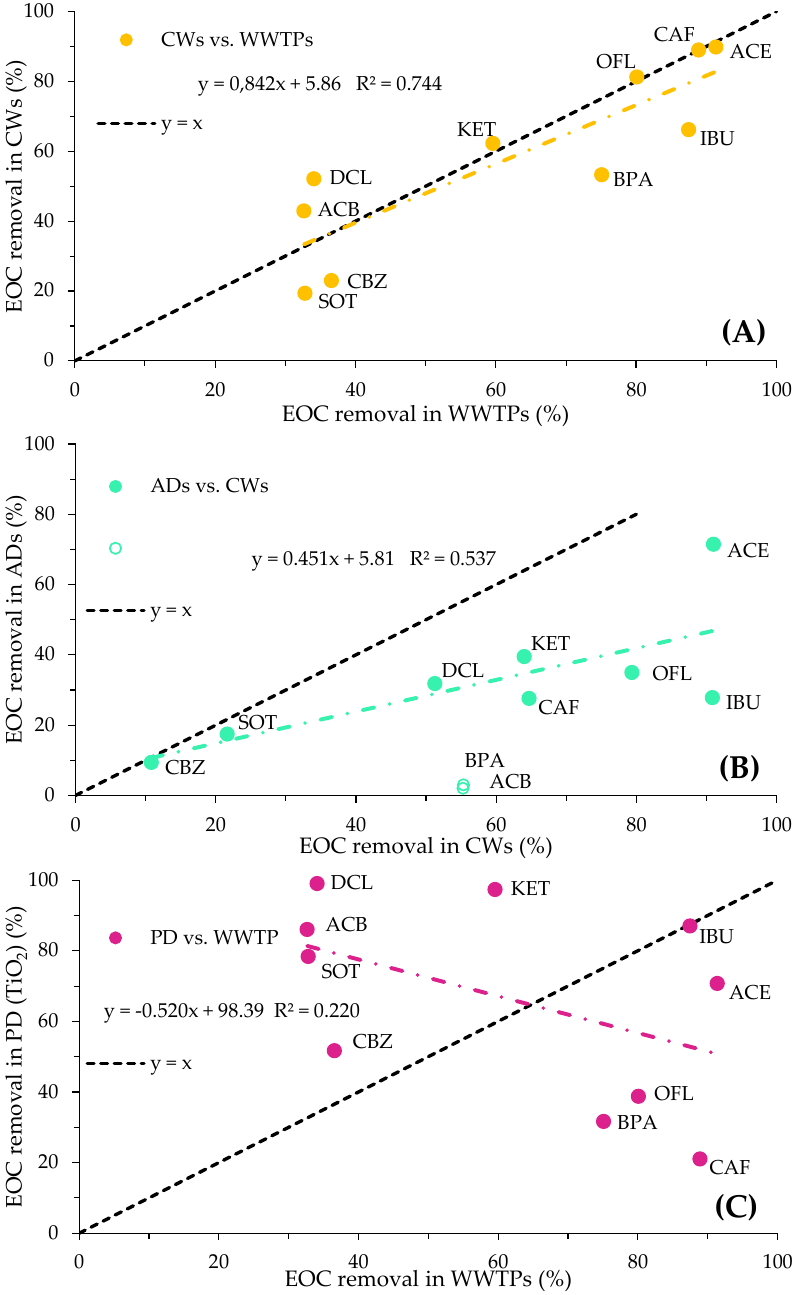
Figure 5. Graphical representation and correlations for EOC removal by different technologies: ( A ) EOC removal in CWs versus WWTPs, ( B ) EOC removal in ADs versus CWs, and ( C ) EOC removal in photodegradation systems (photolysis and photocatalysis with TiO 2 ) versus WWTPs (depicted values were obtained as mean values of the ranges and other values given in Tables S2, S3, S4, and S5). Correlations are statistically significant at a p-level of 0.001 (A) and 0.05 (B, in this case excluding the data for BPA and ACB).